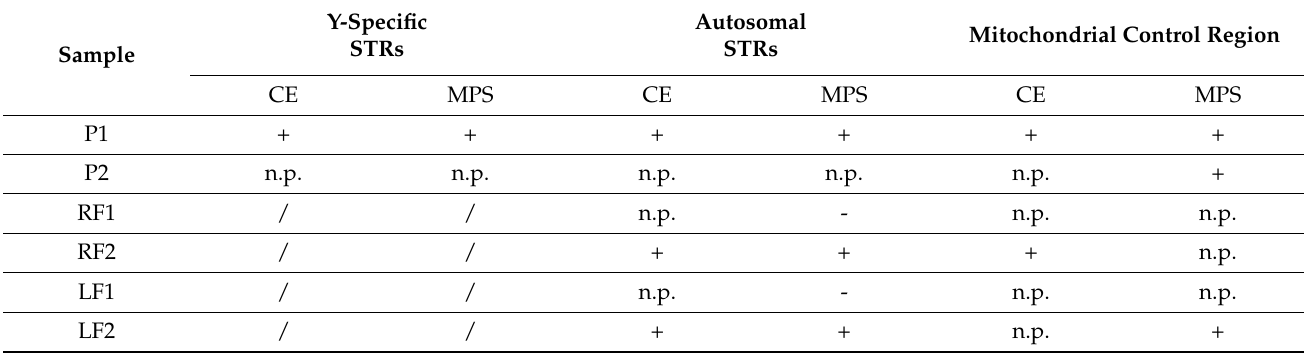
Table 2. Results of the DNA typing by CE (PCR-CE-based systems) and MPS (PCR-MPS-based systems); +: positive outcome (more than 50% of the markers); -: no result; n.p.: not